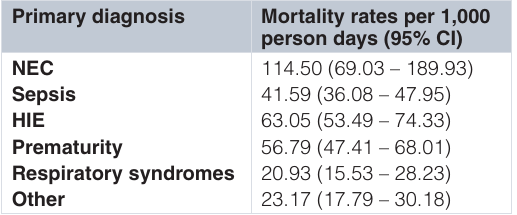
Table 2. Mortality rates per 1,000 person days (95%CI) for the primary diagnoses in Chaman. Primary